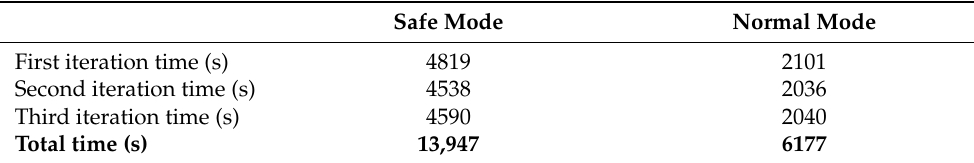
Table 5. Comparison of exemplary iteration test times in safe and normal boot